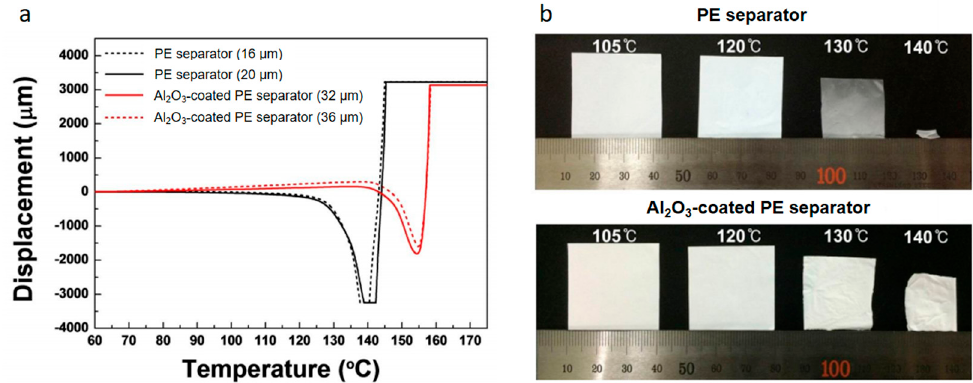
Figure 6. ( a ) TMA thermograms and ( b ) thermal shrinkage of pristine PE and Al 2 O 3 -coated PE separators. Reproduced with permission from [44].